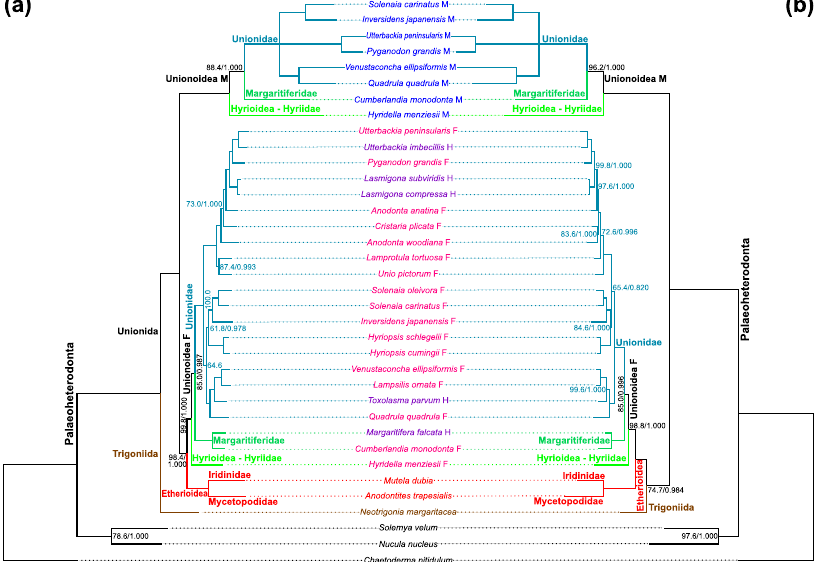
Figure 2. Phylogeny of Palaeoheterodonta. Trees were constructed using ( a ) nucleotide sequence of 12 mtDNA-encoded genes and ( b ) the respective inferred protein sequences of species in Table 1. Only ML trees are shown: topology of BI trees was largely congruent; the few small differences are only described in the main text and below. Support values at a node are shown only if (1) they were not 100% bootstrap support on the ML tree and 1.0 for the posterior probability values on the BI tree, or (2) when a node was only present in the ML tree. Support values, when shown, are presented next to the node as ‘ML bootstrap value/BI posterior probability’. Species names in the middle column are coded with the following colours, according to taxonomy and/or mtDNA type: black, non-Palaeoheterodonta outgroups; brown, Trigoniida; red, Etherioidea; pink, F mtDNA of DUI species; blue, M mtDNA of a DUI species; violet, H mtDNA of a secondarily hermaphroditic unionid. Branches inside Palaeoheterodonta are coloured according to taxa: brown, Trigoniida; red, Etherioidea; bright green, Hyriidae (Hyrioidea); dark green, Margaritiferidae (Unionoidea); aqua blue, Unionidae (Unionoidea). ( a ): A dissimilarity in the ‘Unionoidea F’ clade between BI and ML trees resides in the different position of the branch comprising five species of the subfamily Gonideinae (i.e., H . cumingii , H . schlegelii , I . japanensis , S . carinatus , and S . oleivora ; Table 1) relative to all other Unionidae F/H mtDNAs: in the ML tree here shown, this clade is sister to the cluster containing Ambleminae and Lampsilinae (see Table 1 for those species), while in the BI (not shown) it is sister to the clade containing the other ten F and H Unionidae mt genomes. Because of the positions in both ML and BI trees of L . tortuosa , A . woodiana and U . pictorum , subfamilies Gonideinae and Unioninae (Table 1) are not supported as being monophyletic. ( b ): Both ML and BI protein-based trees differ from the nucleotide-based one in the relative position of L . tortuosa , which branches differently inside the same cluster (compare the two trees in figure). Again, Gonideinae and Unioninae are not monophyletic (Table